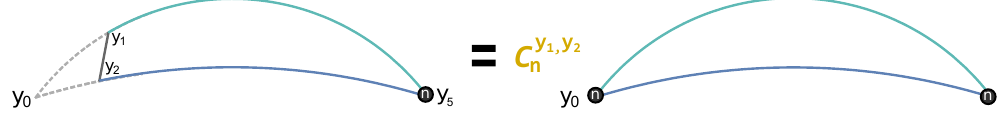
Figure 22 . Graphical representation of equation (9.12) determining the value of C y 1 ;y 2